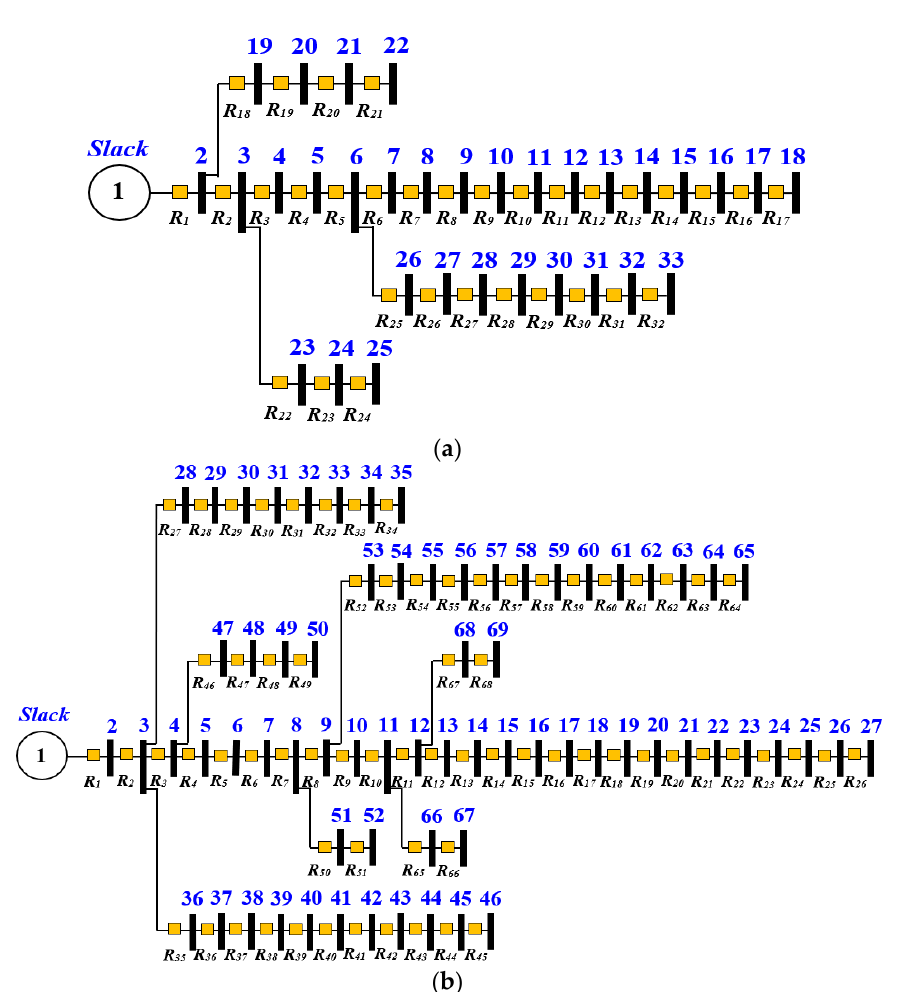
Figure 5. Test systems’ s ingle diagram: ( a ) IEEE 33-bus; ( b ) IEEE 69-bus.